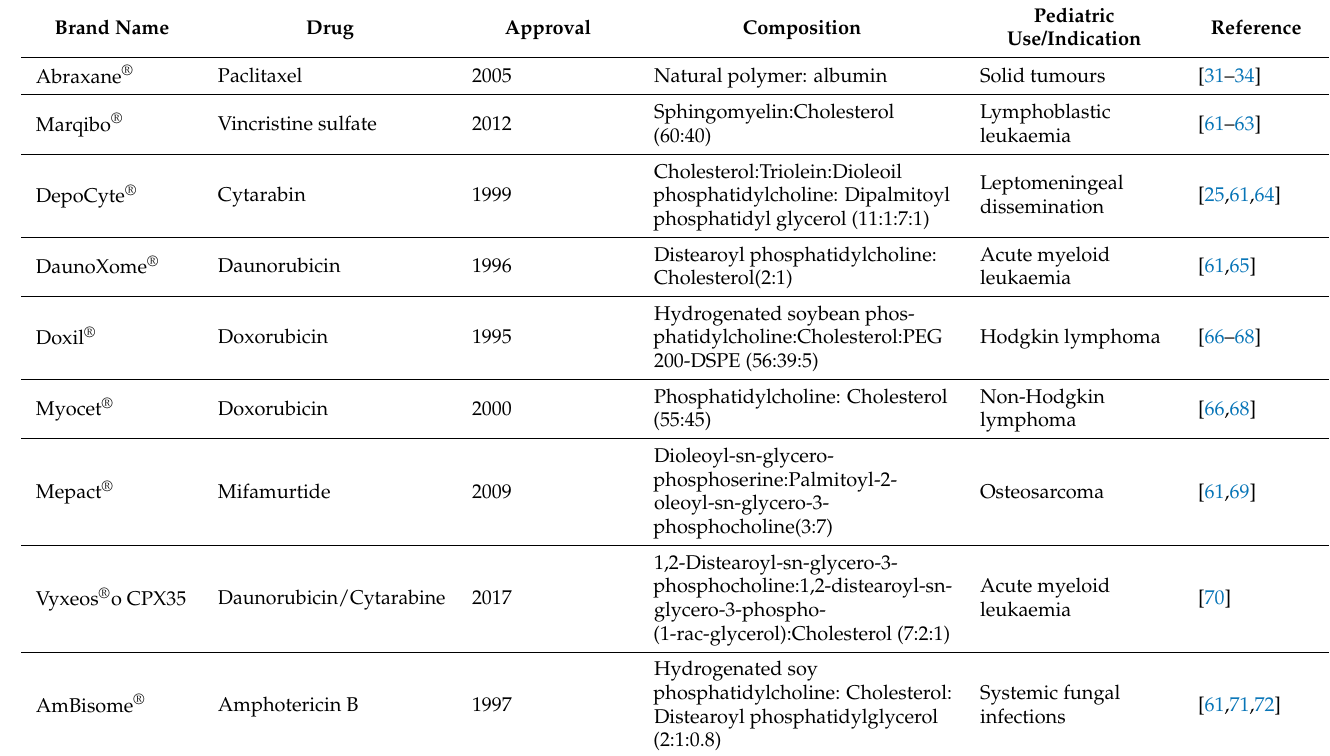
Table 3. Nanoparticle formulations in the